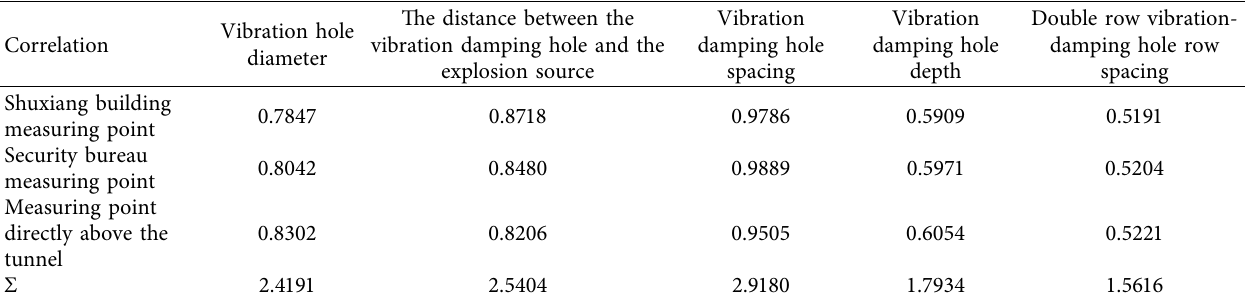
Table 7: Results of grey absolute association